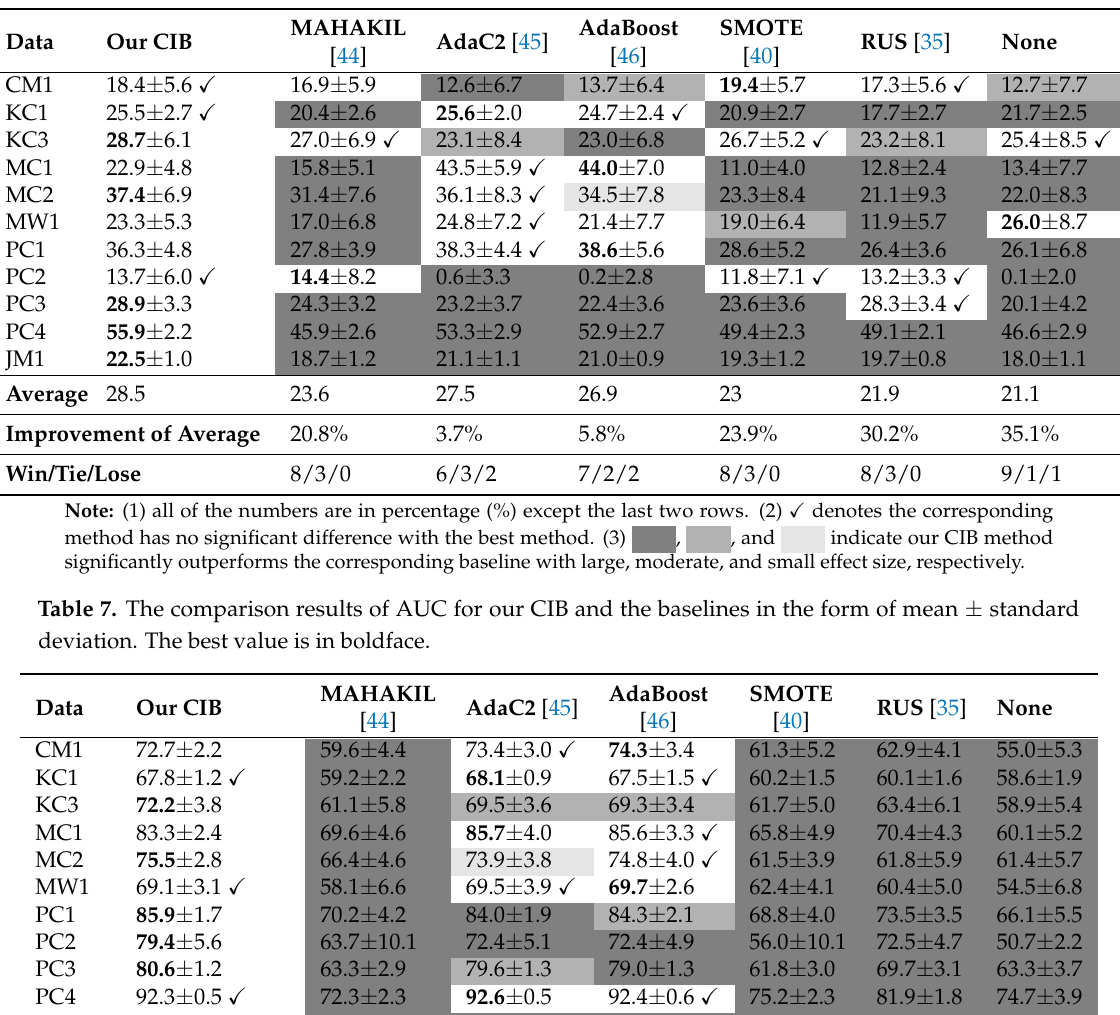
Table 6. The comparison results of MCC for all methods in the form of mean ± standard deviation. The best value is in boldface.